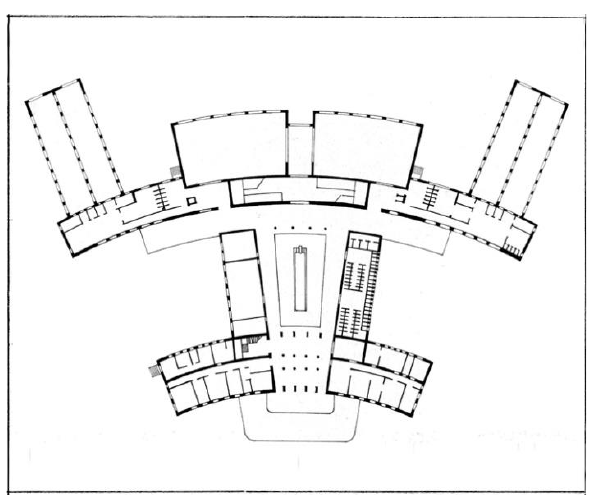
Figure 9. Project drawing. Ground floor